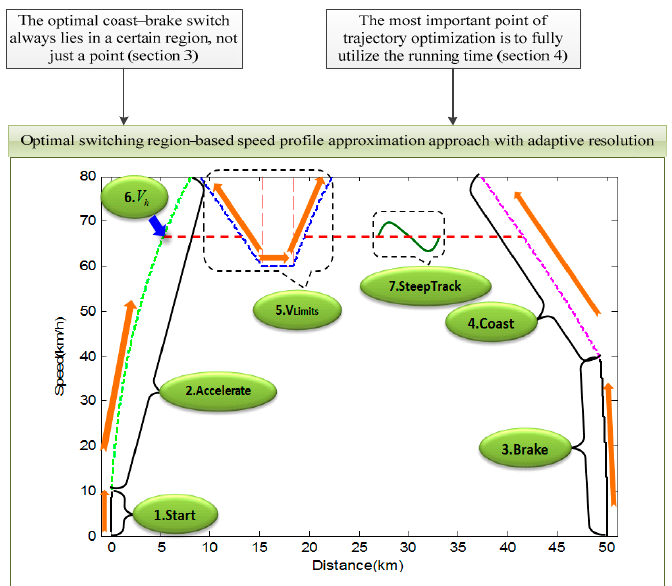
Figure 2. Framework of speed profile optimization.